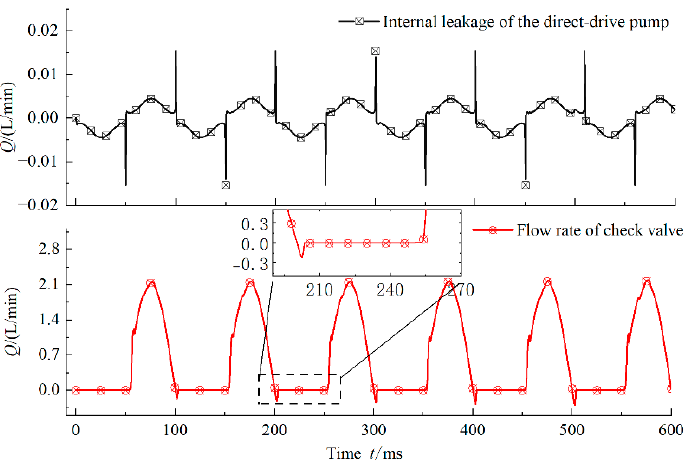
Figure 10. Response curve of instantaneous flow.